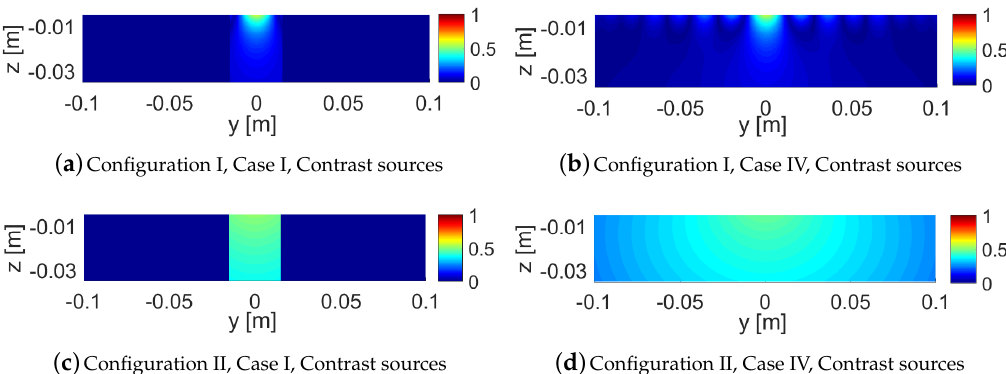
Figure 8. Induced contrast sources (their magnitudes) for Cases I and IV for both configurations: with the NF plate (Configuration I), and without the NF plate (Configuration II). The contrast sources in each configuration have been normalized with respect to the maximum of the incident field at that